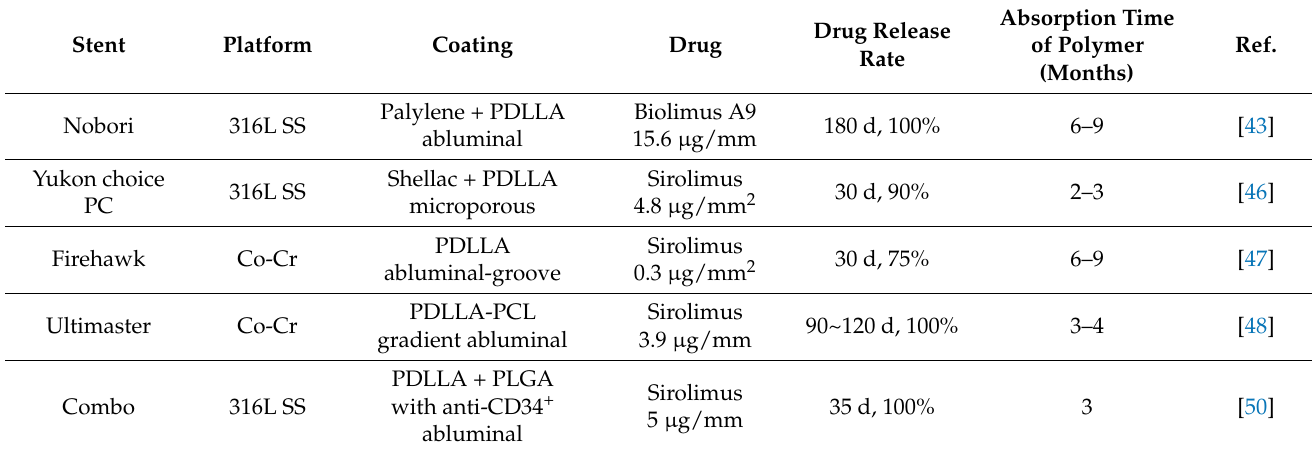
Table 3. DESs with poly-D,L-lactic acid (PDLLA).